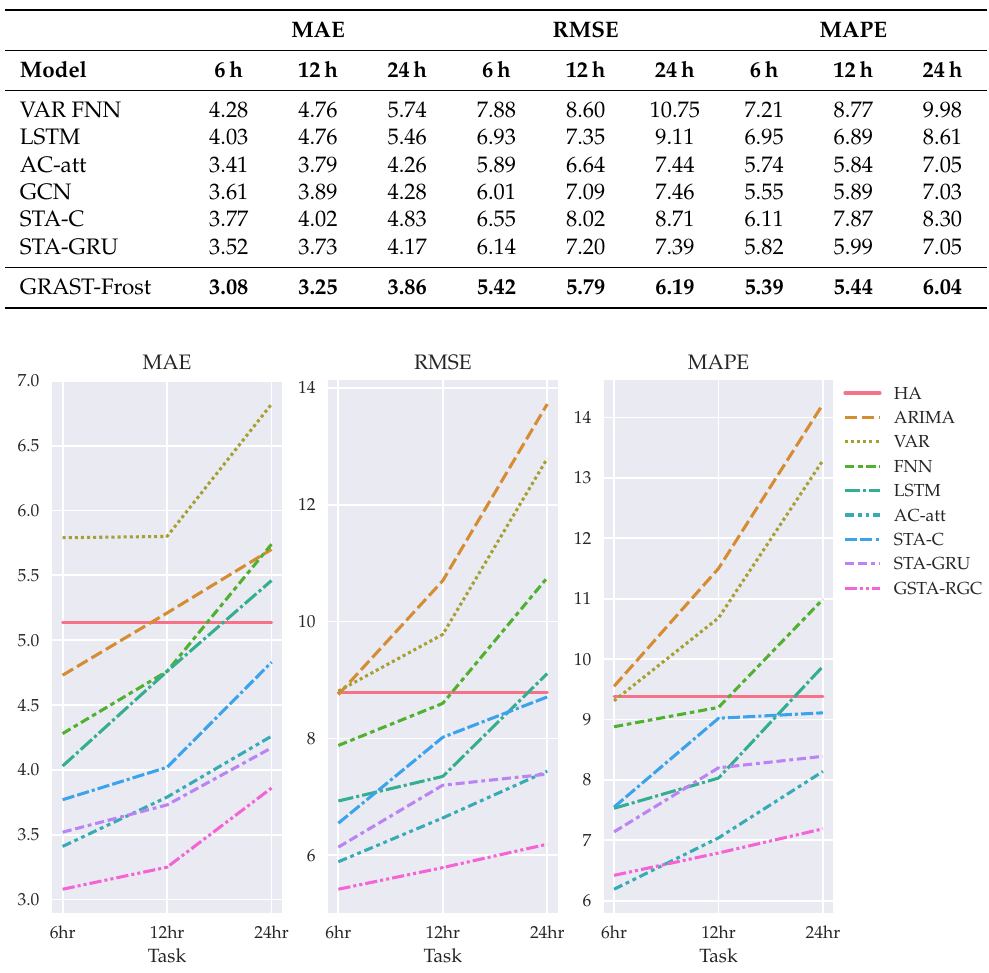
Table 1. Average mean absolute error (MAE), root mean square error (RMSE), and mean absolute percentage error (MAPE) metrics of time series forecasting models applied to frost forecast. Best values are highlighted in bold.